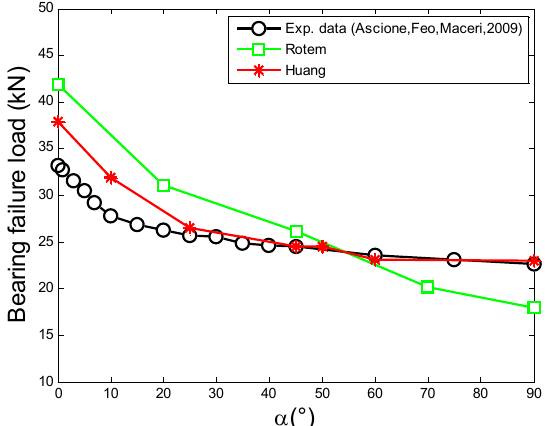
Figure 4: Comparison of predicted failure load with experimental